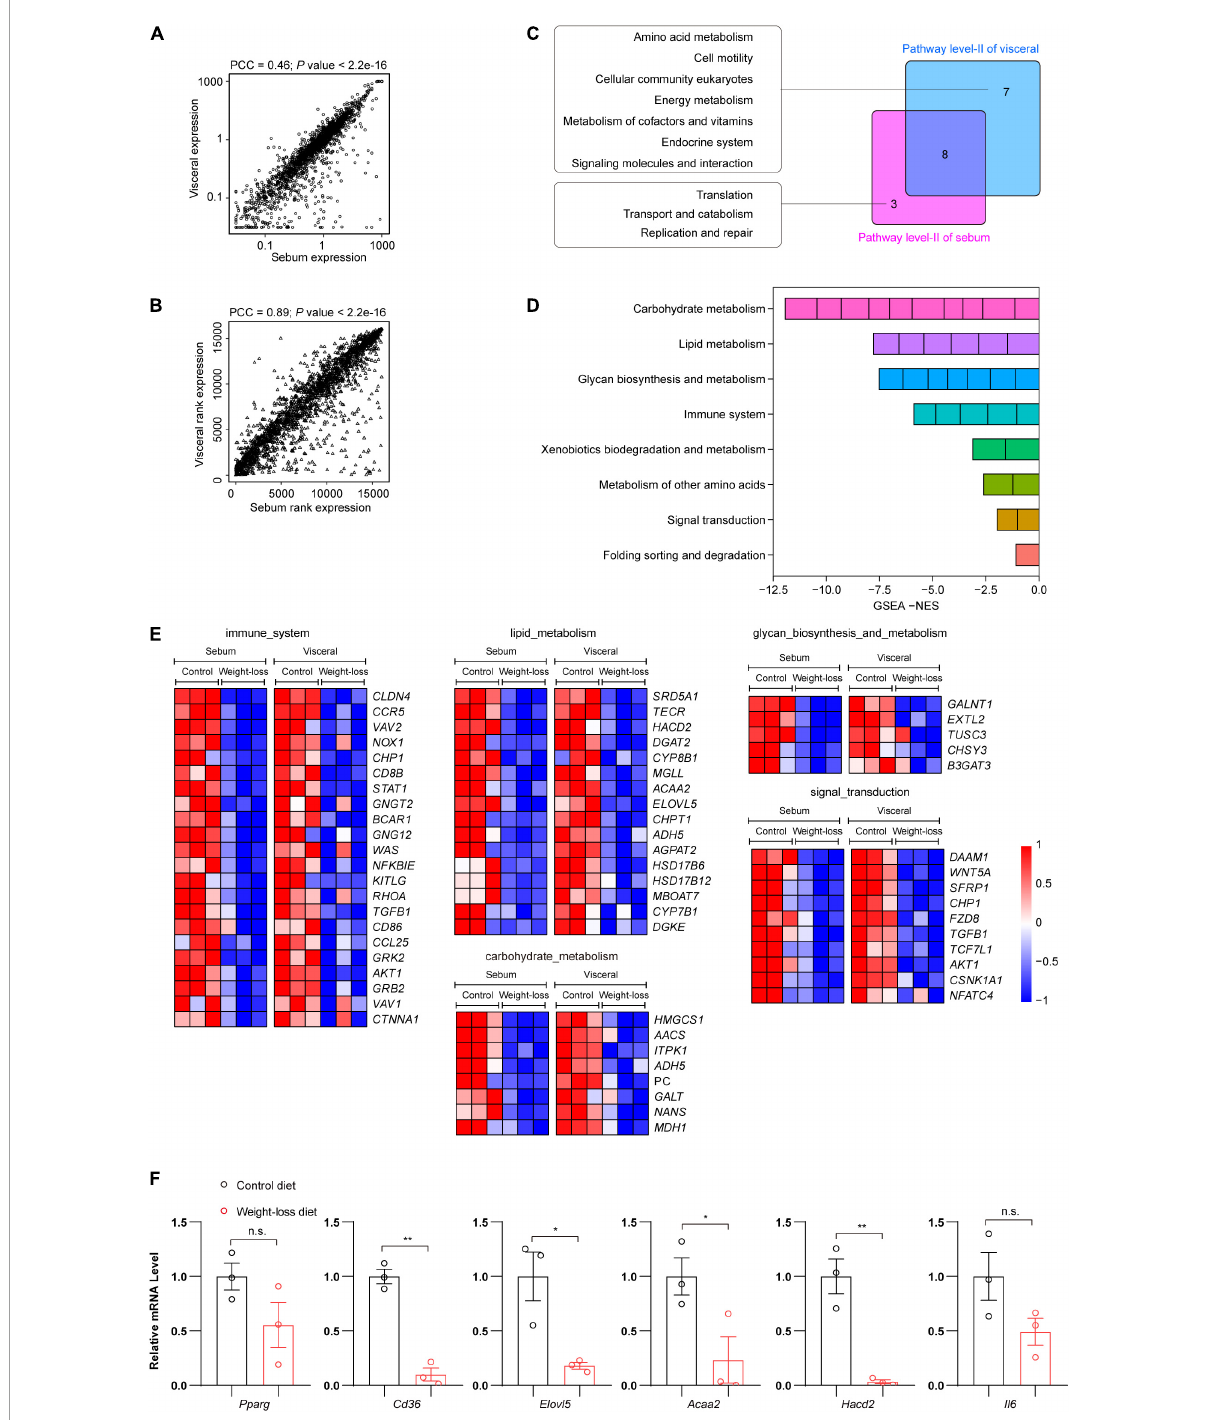
FIGURE6 The weight-loss diet effectively ameliorated the whole metabolic and immune profiles in adipose tissues. (A) Correlation analysis of total gene expression in RNA-seq between subcutaneous and visceral adipose tissues. (B) Correlation analysis of gene expression rank in RNA-seq between subcutaneous and visceral adipose tissues. (C) A venn diagram showing the numbers of unique and shared regulated molecular events between subcutaneous and visceral adipose tissues. (D) Detailed information on the shared regulated molecular events from the RNA-seq analysis. (E) Heatmaps of the core events regulated by the weight-loss diet in the subcutaneous and visceral adipose tissues. (F) Representative gene expression in subcutaneous adipose tissues by qPCR analysis. The data in panel (F) are presented as the means ± SEMs and were analyzed by Student’s two-tailed t -test. * P < 0.05, ** P < 0.01; n.s., not